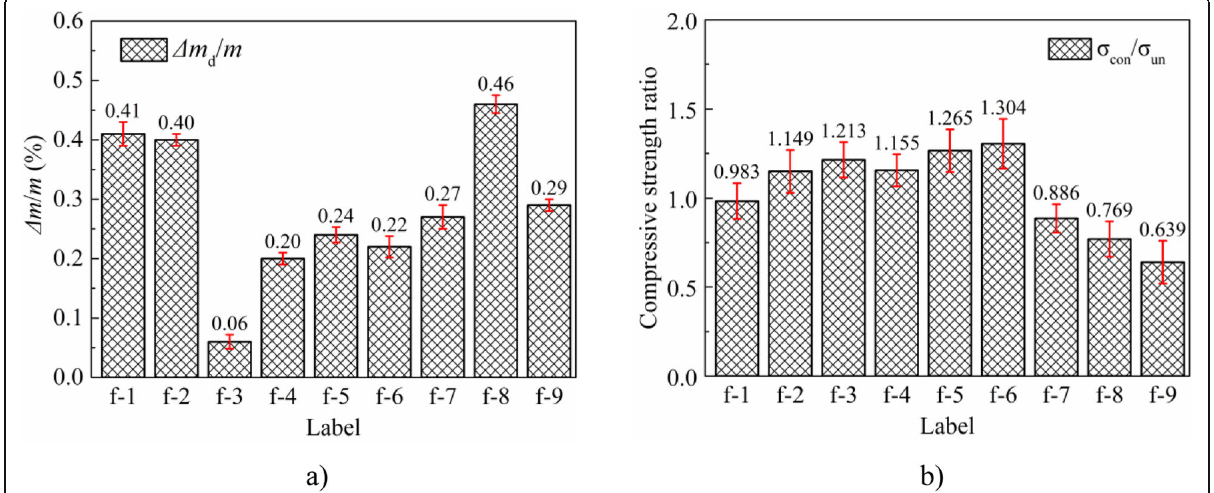
Fig. 6 Difference of SCGAAC subjected to 50 freeze-thaw cycles: a) absolutely dried mass; and b) compressive strength